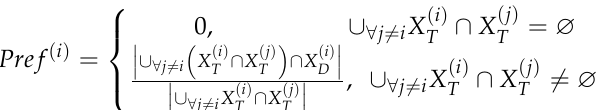
Figure 4. Example of a Class 1 preference area in the ambiguity region (cid:4672)𝑋